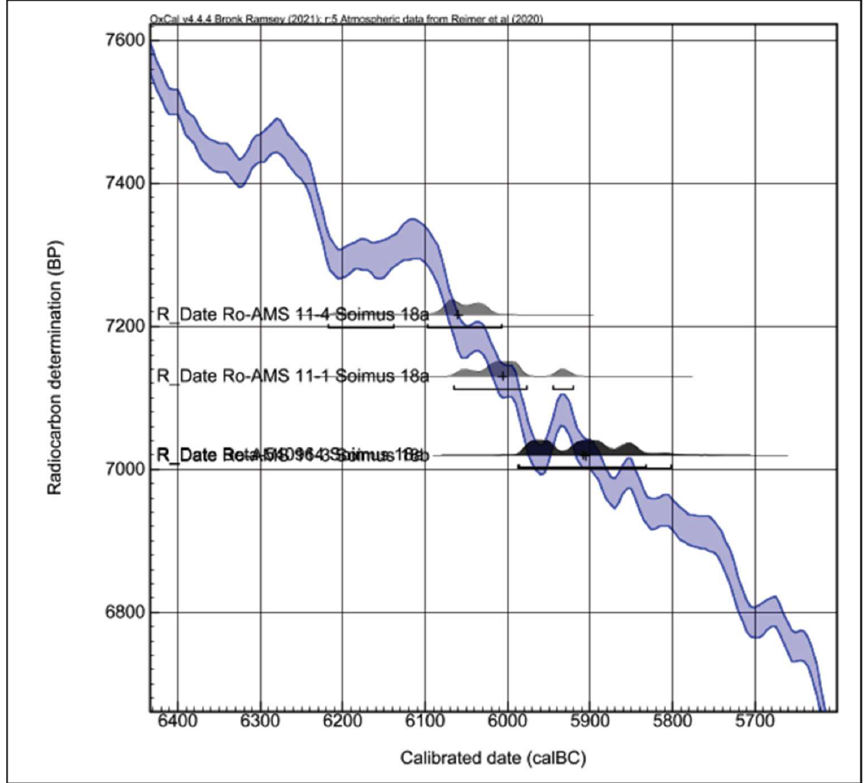
Figure 6. Calibration curve of C14 data from the features C.18a and C.18b—site Şoimuş-Teleghi .